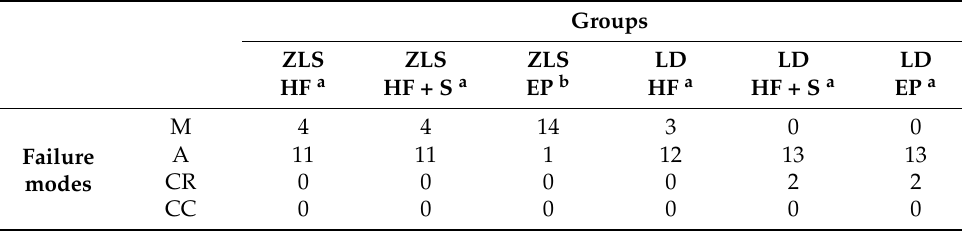
Table 2. Failure mode: M = mixed, A = adhesive, CR = cohesive in resin cement, and CC = cohesive in ceramic. Different letters label statistically significant differences in failure modes’